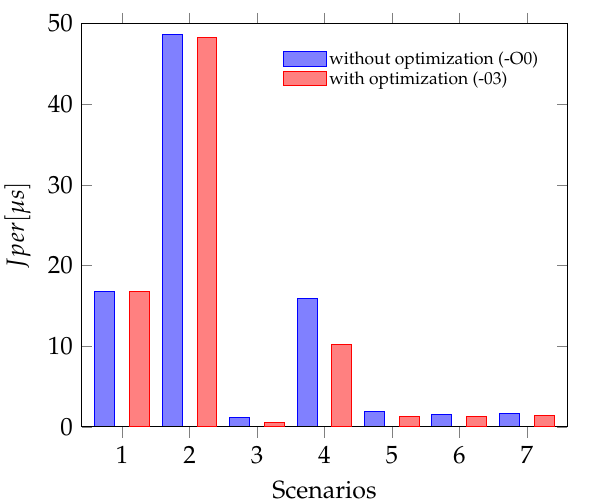
Figure 14. Periodic Jitter with and without optimization (Scenario numbering as in Table